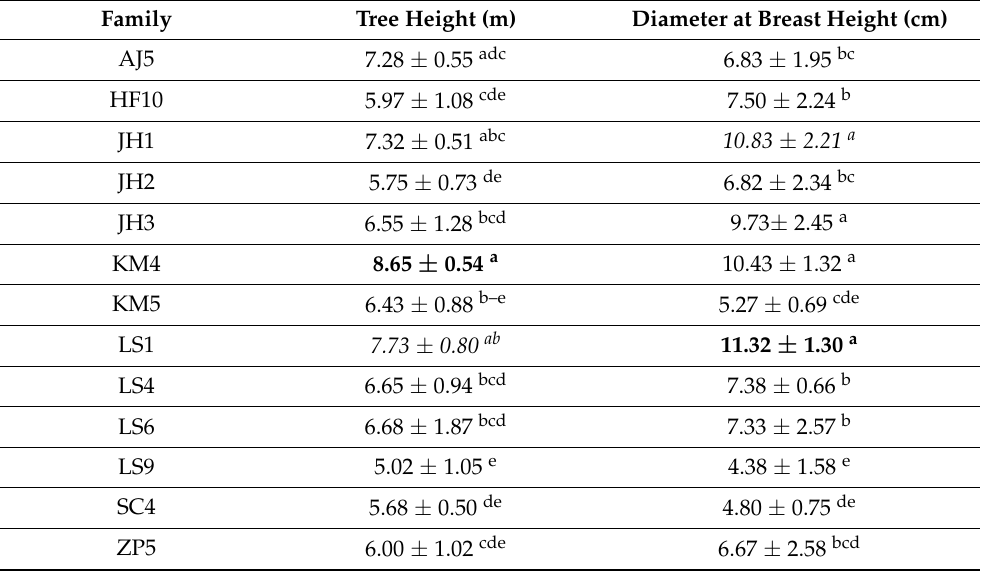
Table 1. Mean tree height and diameter at breast height (DBH) values for Cyclocarya paliurus (Batal.) Iljinskaja genotypes across two test